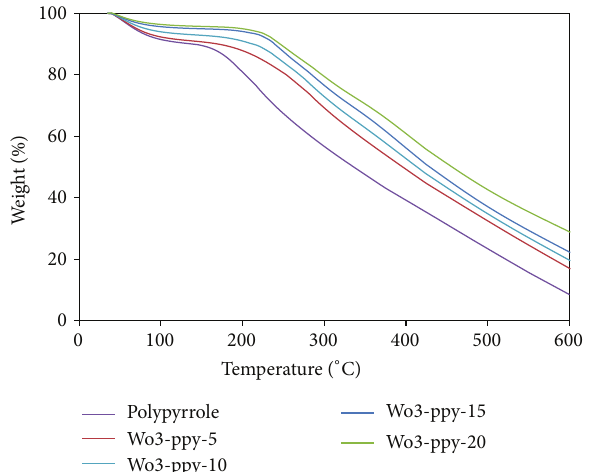
Figure 3: Thermogravimetric curves of the pure PPy and WO 3 -Ppy PNCs.